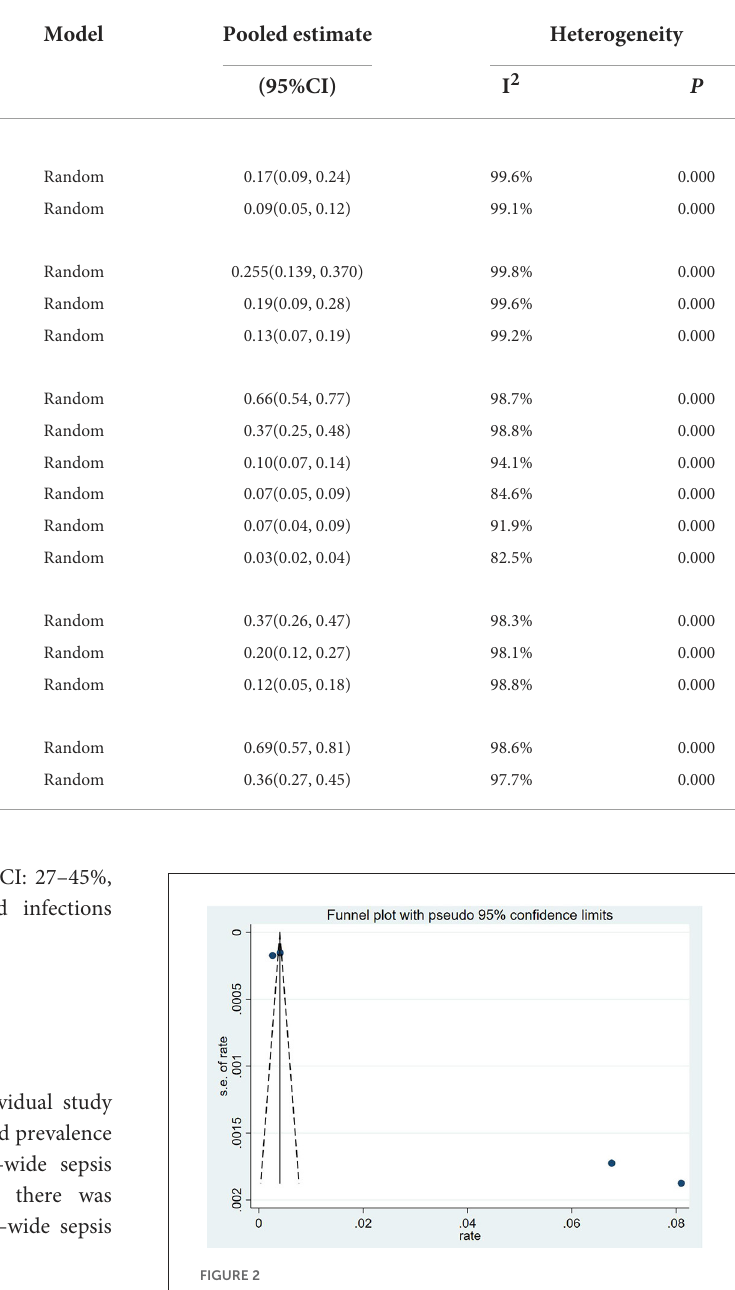
TABLE 7 Subgroup analysis of the prevalence of ICUs sepsis.